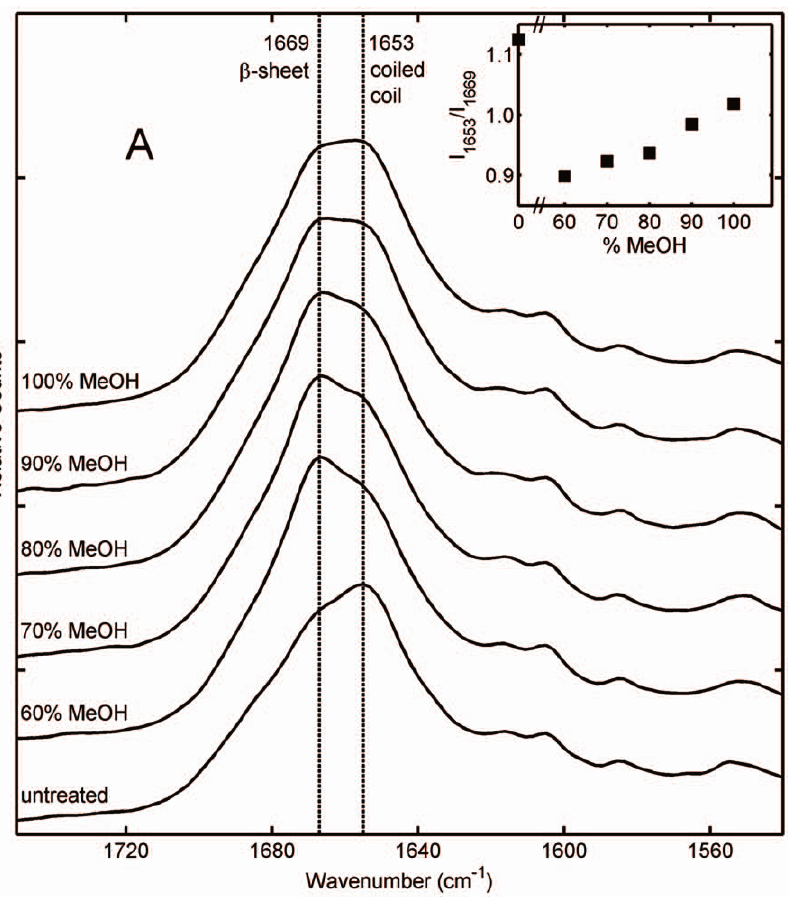
Figure 1. Raman spectra of honeybee silk sponges immersed for 48 hours in aqueous methanol solutions containing 60–100% methanol. Inset shows the approximate ratio of Raman intensity at 1653 cm 2 1 (attributed to coiled coil protein structure) to intensity at 1669 cm 2 1 (attributed to ß-sheet protein structure) for different samples.